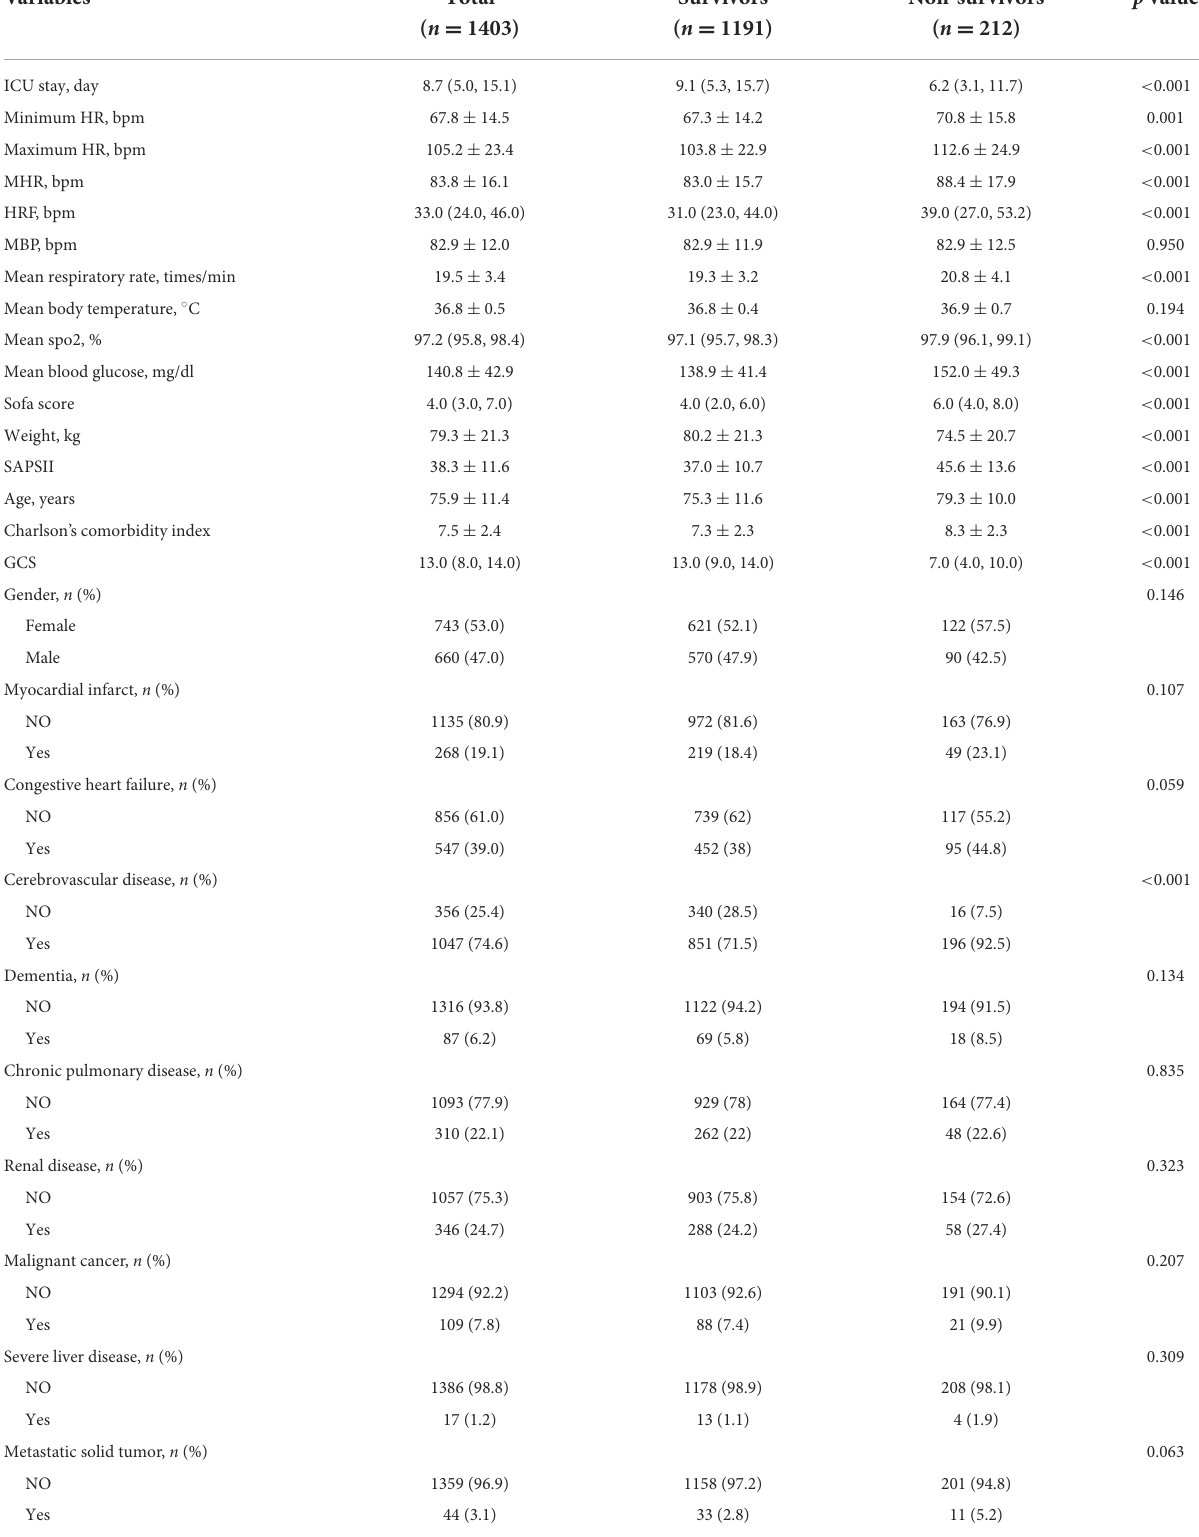
TABLE 1 Baseline characteristics of patients stratified by 30-day